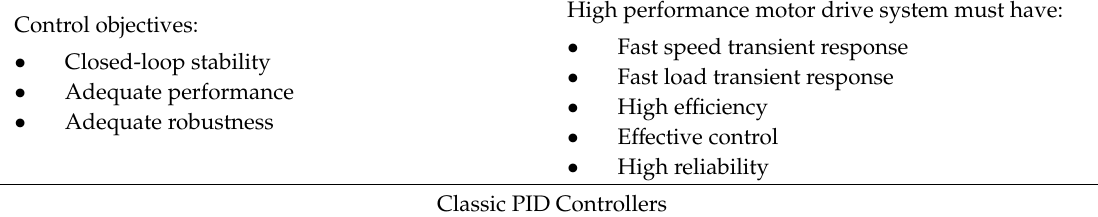
Table 3. Control techniques for brushed DC motors drives.